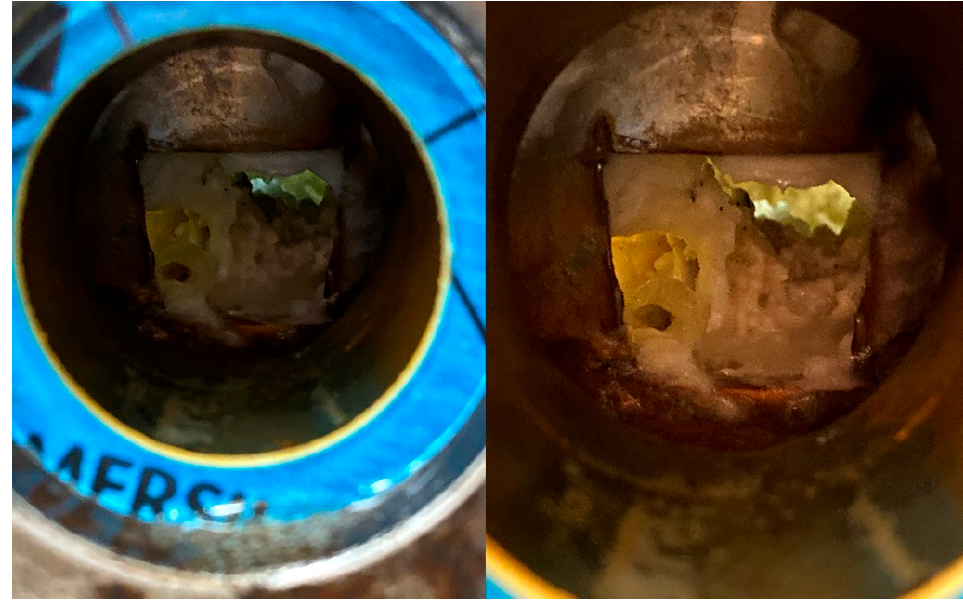
Figure 8. Formed natural gas hydrate, scale 1:1